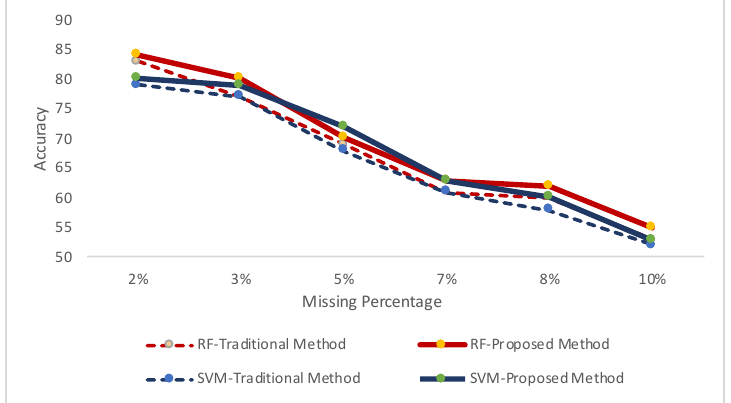
Figure 9. Missing data analysis for some activities of single chest